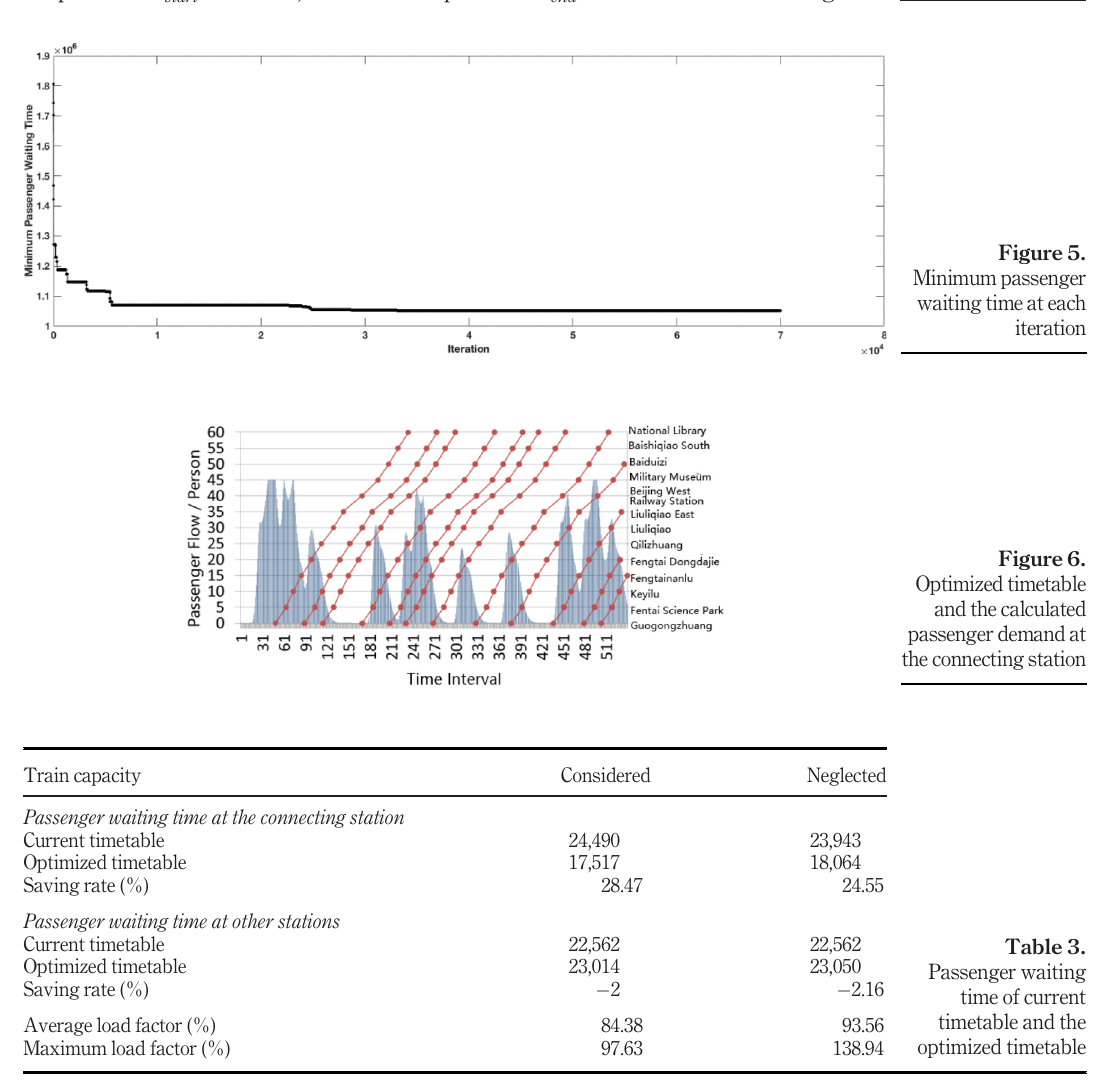
Figure 5. Minimum passenger